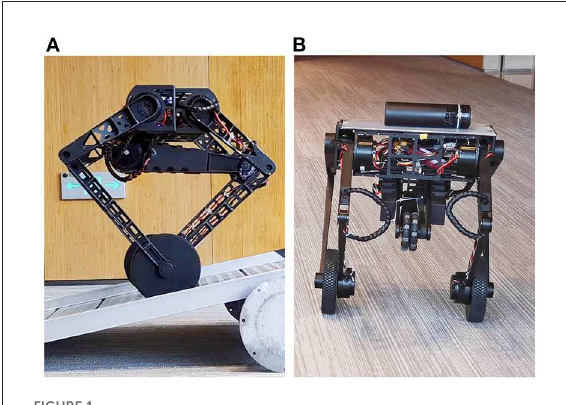
FIGURE1 The wheel-legged robot Ollie. Many more maneuvers in action and experimental data are shown in the accompanying video. (A) Train the controller on a slope. (B) Test the controller to balance a cup.